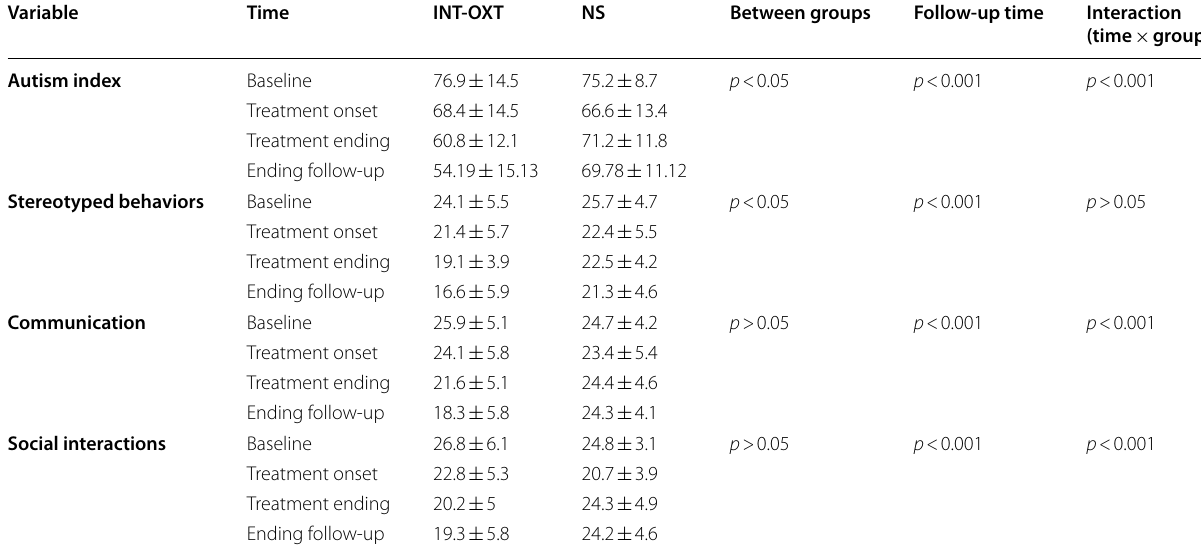
Table 2 Gilliam Autism Rating Scale-2 (GARS-2) mean scores